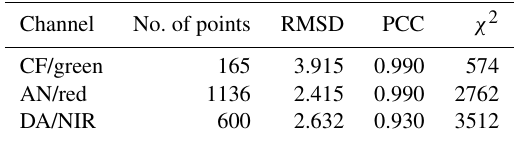
Table 5. Performance statistics showing the high correlation be- tween the original and the reconstructed MISR L1B2 radiance data over clear land masses when missing data are artificially introduced to the original data files for G LOBAL M ODE P168, O065487, B110. The numbers of clear land values involved depend on the cloudiness present in the scene and therefore on the position of the artificially introduced lines of missing data within the B LOCK